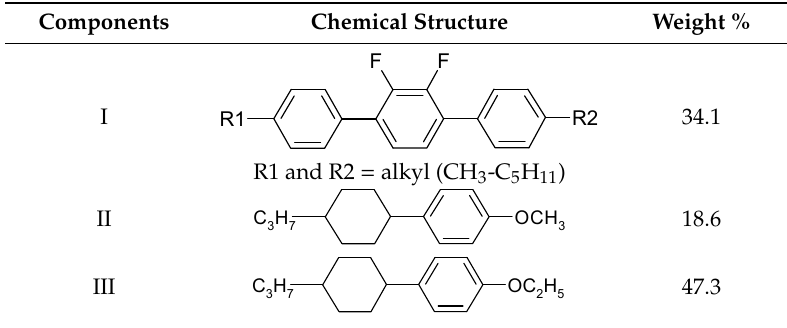
Table 1. General molecular structures of compounds used to form the investigated 2050 nematic mixture and their weight %.